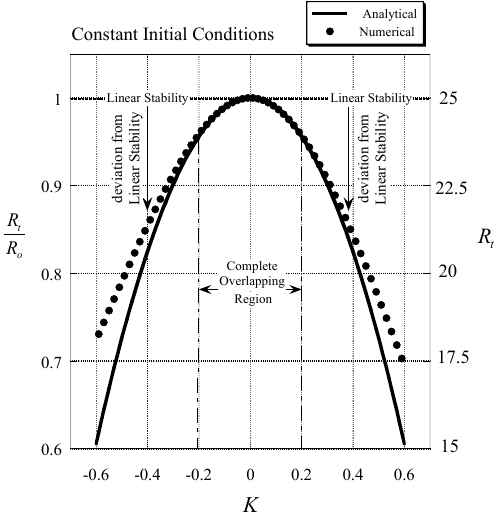
Figure 7. Transitional subcritical values of the scaled Rayleigh number R t as a function of the feedback gain controller parameter K corresponding to constant initial conditions of (cid:101) X o = (cid:101) Y o = (cid:101) Z o = 1 = constant [51]. (Reproduced with permission from Peter Vadasz, Transport in Porous Media; published by Springer, 2010.) Fluids 2017 , 2 , x FOR PEER REVIEW